Question: What style of plot is this figure drawn as?
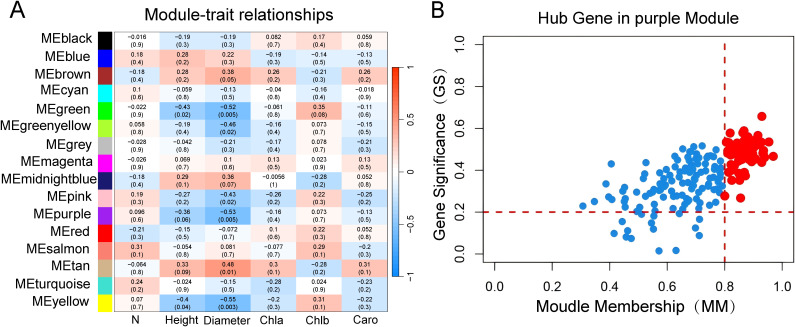
Answer: scatter